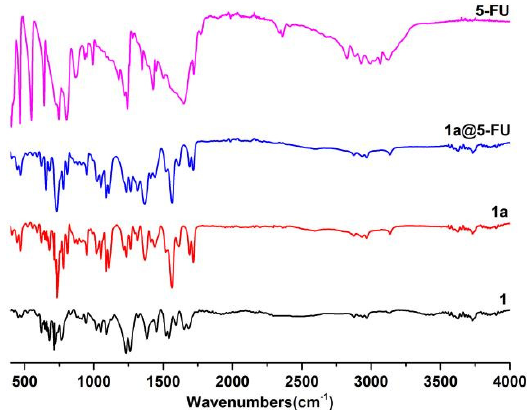
Figure 3. IR spectra of complex 1 , complex 1a , 5-FU@ 1a, and 5-FU.